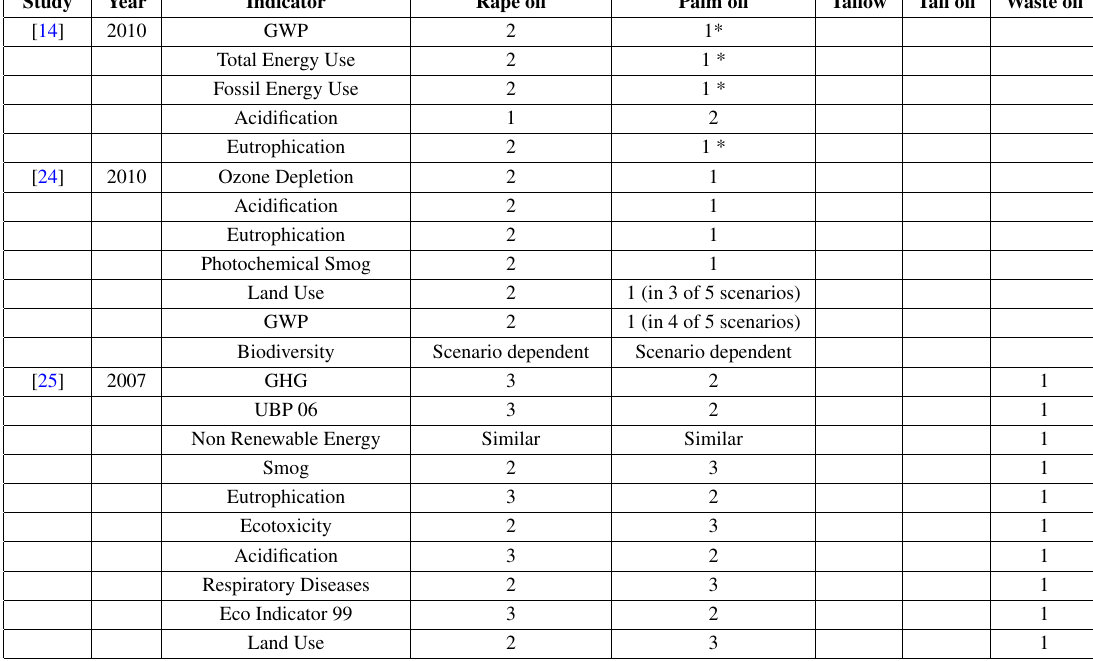
Qualitiative ranking of feedstocks based on LCA studies that rank different